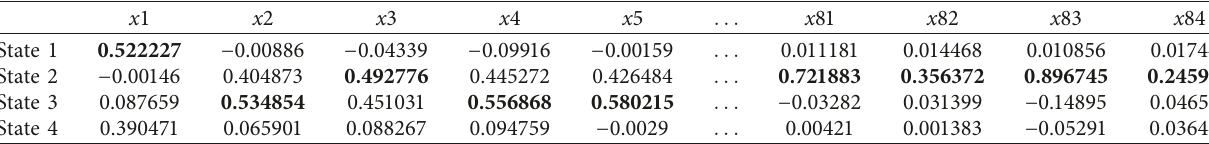
Table 6: Cross-validation set identification rate.